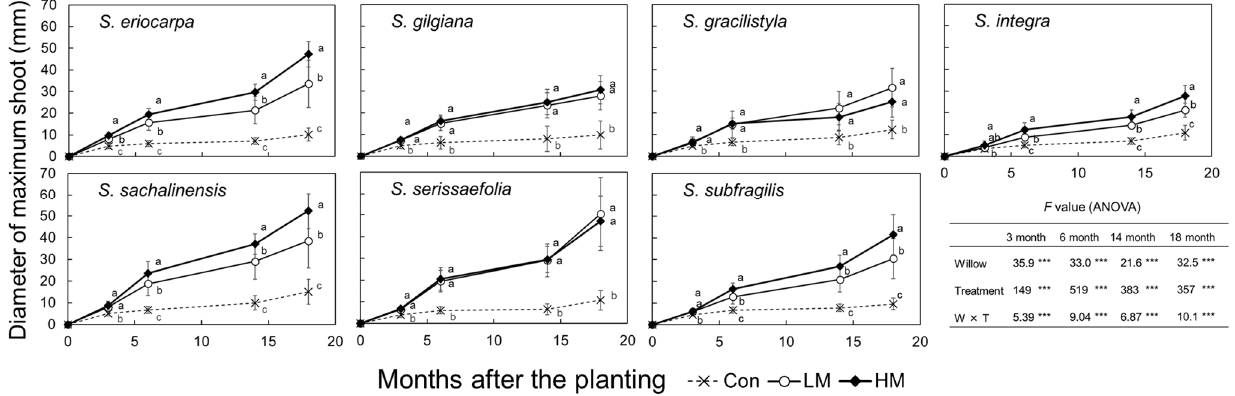
Figure 5. Diameter of largest shoot of individuals of seven willows grown under three treatments (mean ± SD). The number of individuals were as shown in Table 3. Asterisks indicate significant differences among seven willows, three treatments, and their interaction (W × T) calculated by ANOVA (*** = p < 0.001). Different alphabetical letters indicate significant differences between the three treatments based on Tukey test ( p < 0.05).